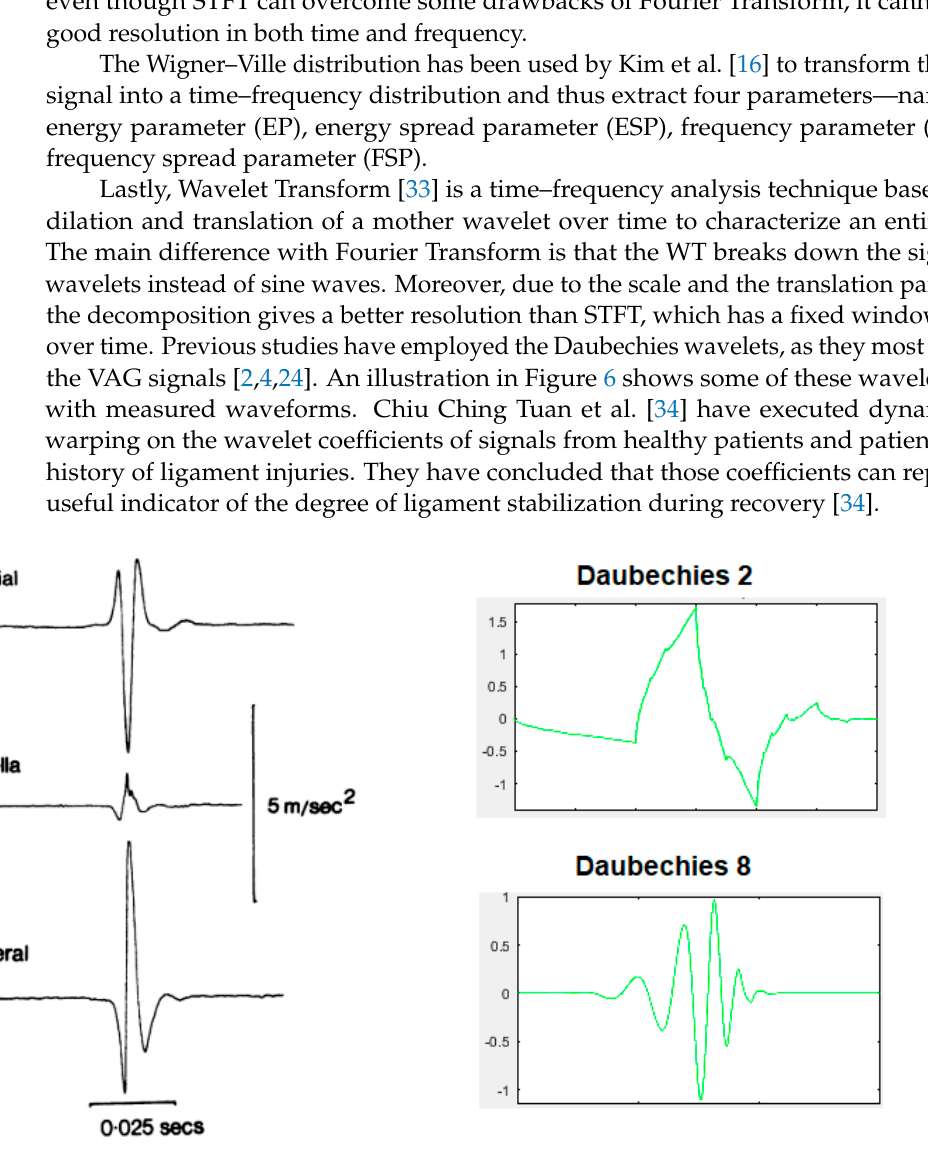
Figure 6. ( A ) A typical signal encountered in VAG data is a short-duration “click”. Here, it is measured by three accelerometers and is associated with the posterior horn tear of the meniscus by McCoy [7]. ( B ) Typical wavelet forms are used in the post-processing of VAG signals. Daubechies wavelet was used because of its resemblance with short-duration pulses of the VAG signal.